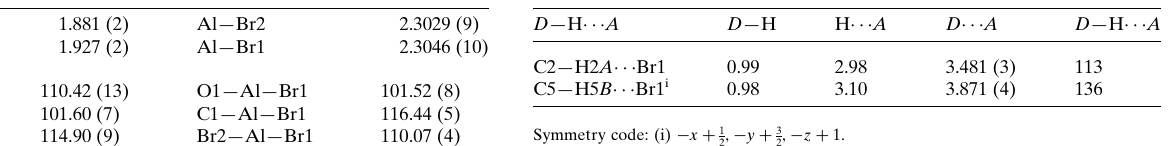
Table 1 Selected geometric parameters (A˚ , (cid:2) ).